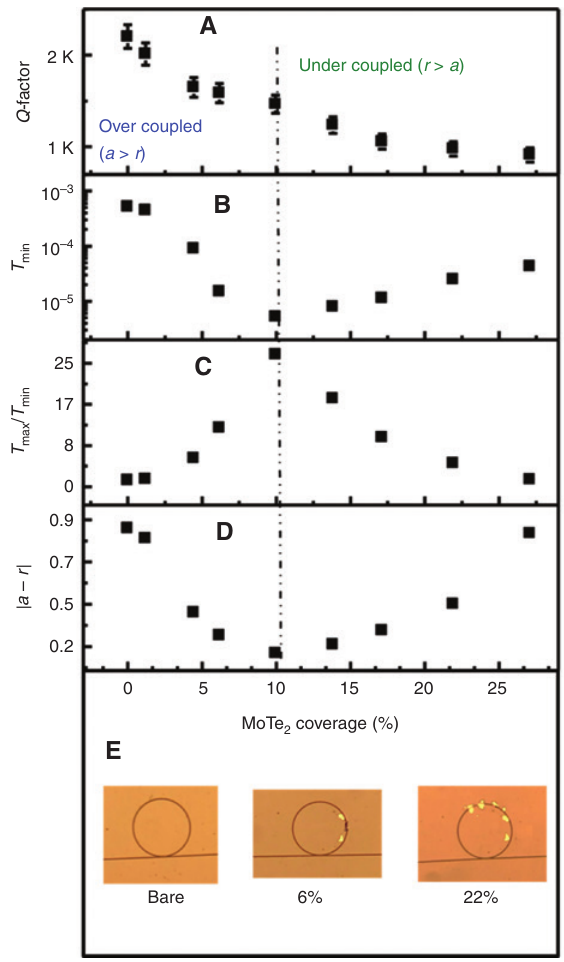
Figure 2: TMD-loaded tunable coupling effect. Variation of (A) Q factor, (B) minimum transmission ( T (C) visibility ( T / T ), (D) difference between the self-coupling max min coefficient and the roundtrip transmission coefficient | a – r | as a function of MoTe coverage. The monotonic decrease of 2 Q factor suggests increasing loss for higher coverage, i.e. more transferred TMD. Tunability of coupling effect, i.e. transition from the overcoupled to the undercoupled regime via critical coupled condition (dashed vertical line), is evident from the variation of T T / T , and | a – r |. (E) Corresponding figures for different coverage max min (bare ring, 6% and 22%) showing the advantages of precise transfer by 2D transfer index of the 2D materials at telecom wavelength (1.55 μ m).